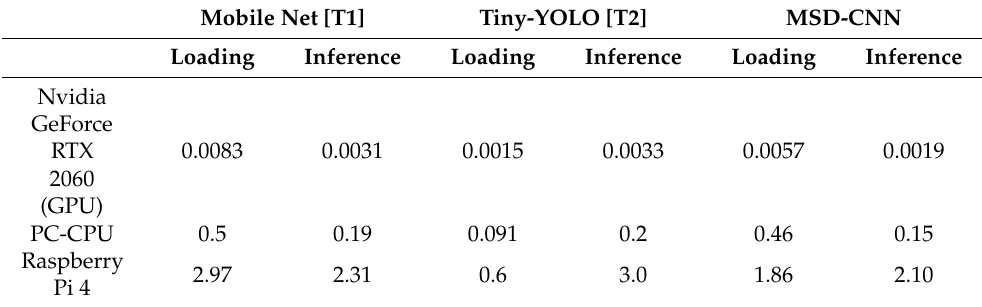
Table 7. The computational cost of detecting models on different computing